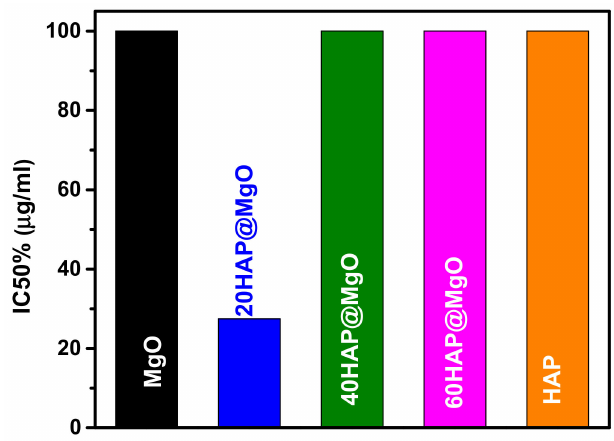
Figure 7. The IC 50 values of the different composites against HepG2 cells by SulphoRhodamine-B (SRB) assay. HepG2 cells were exposed to various concentrations of HAP@MgO composites for 48